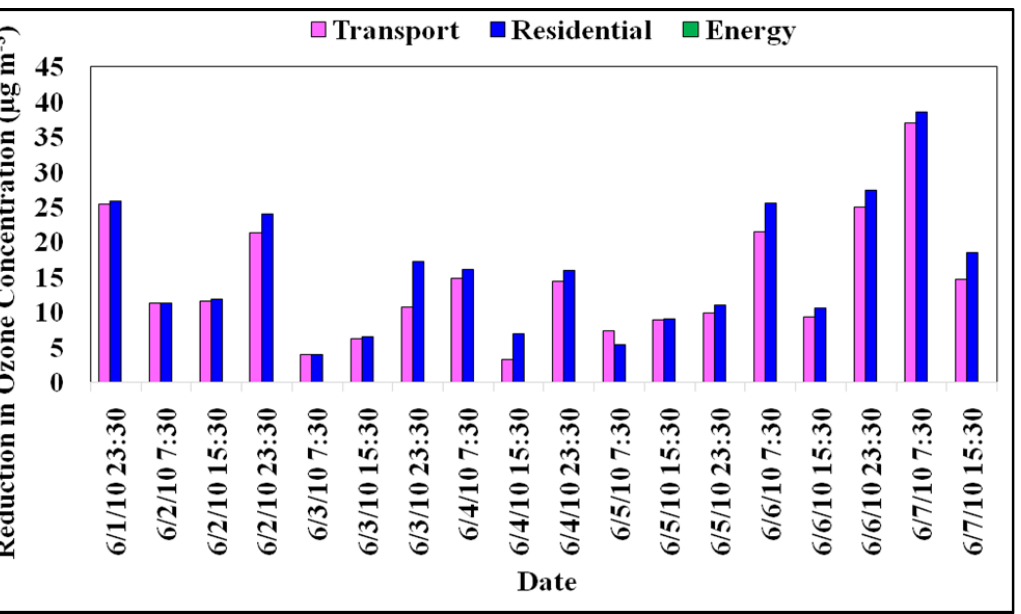
Figure 5. Reduction plots of simulated ozone concentrations (µg m −3 ) representing the difference between original and proposed emission scenarios for transport (pink), residential (blue), and energy (green) sectors, averaged for the entire simulation period over the Delhi domain. Note: No change in concentration was noted in the energy sector.